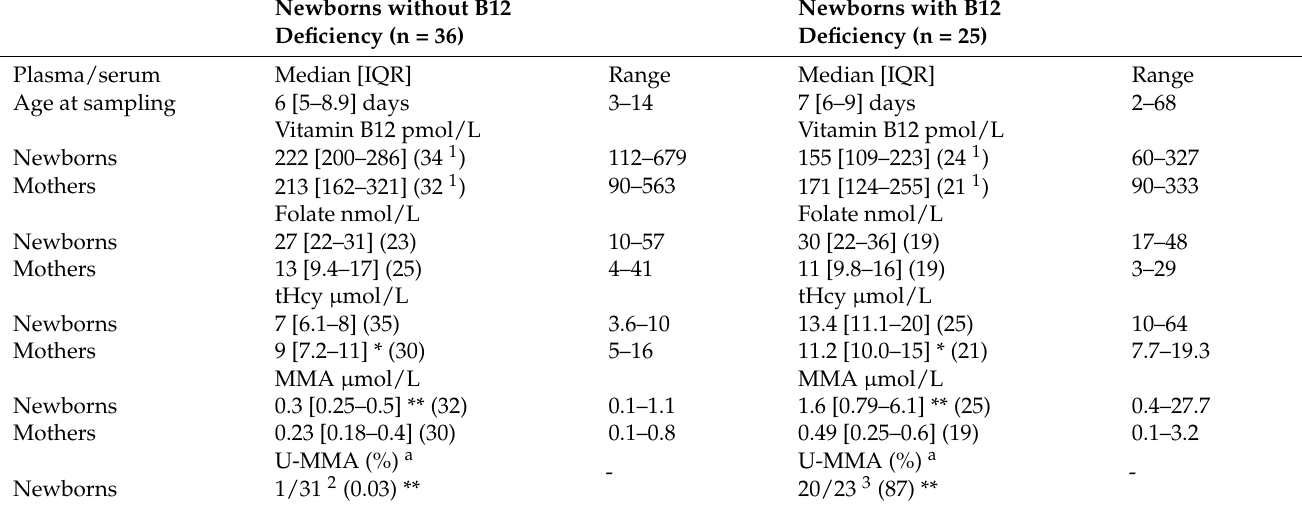
Table 1. Confirmatory B12 status in newborns reported with false positive results for methylmalonic acidemia and propionic acidemia (n = 61) and their mothers. Categorized with and without B12 deficiency. Numbers are given with median, interquartile range and range. The number in parenthesis is the number of cases with available